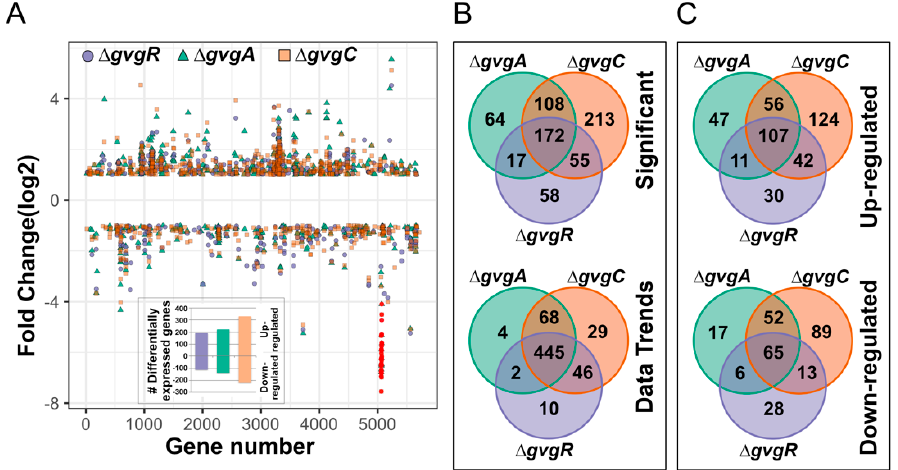
Figure 2. Differentially expressed genes in Δ gvgR , A , and C strains. ( A ) Genes significantly differ- entially expressed (|Fold change| > 2, FDR p -value < 0.05) in Δ gvg R , A , and C strains plotted across the WH6 genome. Red circles indicate the gvg cluster genes. The inset shows the numbers of up- and down-regulated genes in each knockout strain. ( B ) Overlap of differentially expressed genes for each strain. The top diagram represents the significantly different data set, while the bottom represents the manually curated data set for similar trends in the data. ( C ) Overlap of up- (top) and down-regulated (bottom) statistically significant differentially expressed genes in Δ gvg R , A , and C strains. Table 2. Top ten similarly regulated genes in gvg cluster mutants compared to wild type WH6. Strain Locus Tag